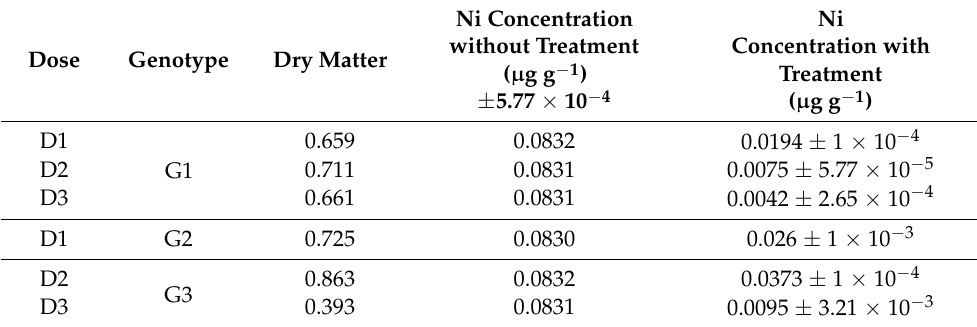
Table 5. Ni +2 concentrations with respect to the dry matter obtained from the aerial part of each seedling. Ni Concentration Ni without Treatment Concentration with Dose Genotype Dry Matter ( µ g g − 1 ) Treatment ± 5.77 × 10 − 4 ( µ g g − 1 ) D1 0.659 0.0832 0.0194 ± 1 × 10 − 4 D2 0.711 0.0831 0.0075 ± 5.77 × 10 − 5 G1 D3 0.661 0.0831 0.0042 ± 2.65 × 10 − 4 D1 G2 0.725 0.0830 0.026 ± 1 × 10 − 3 0.0095 ± 3.21 × 10 −